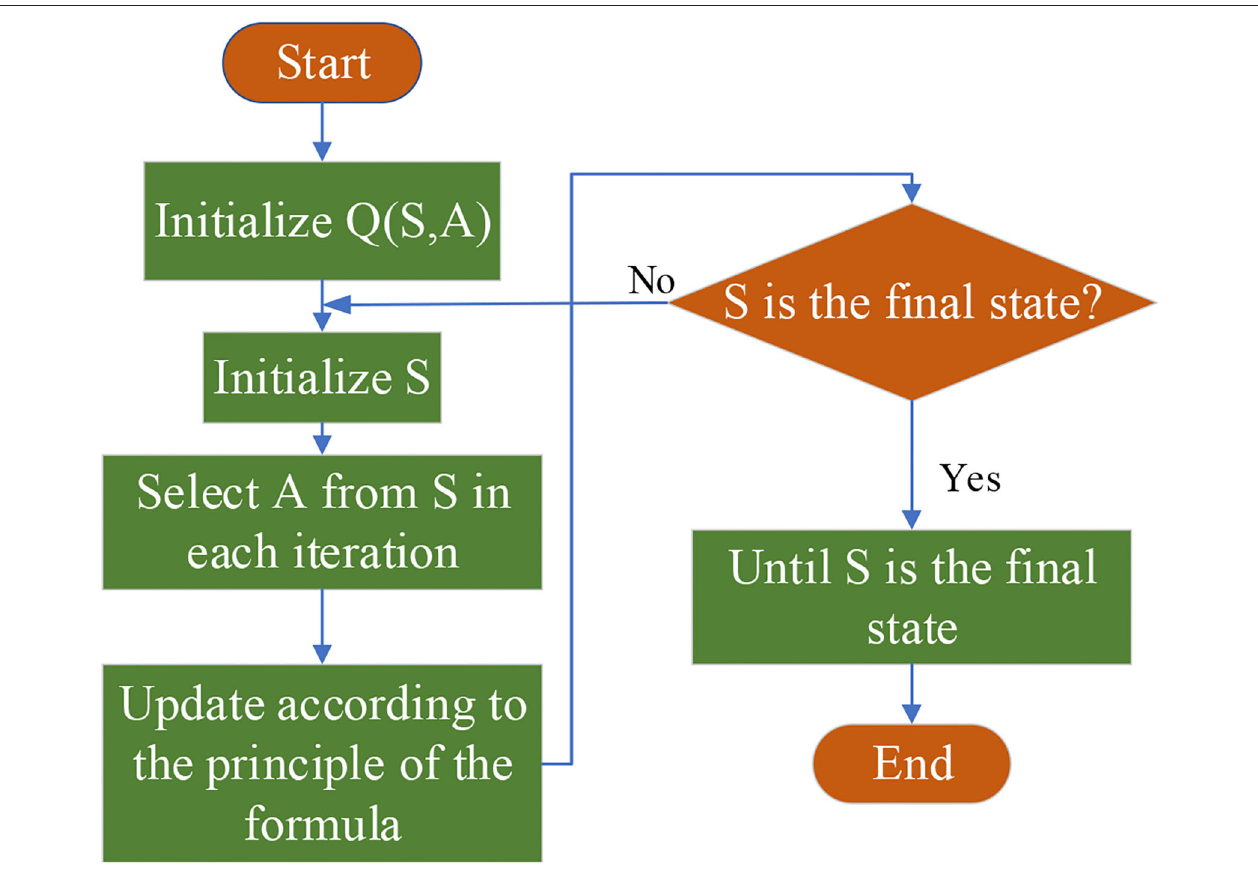
FIGURE 1 | Quality learning (Q-Learning) algorithm